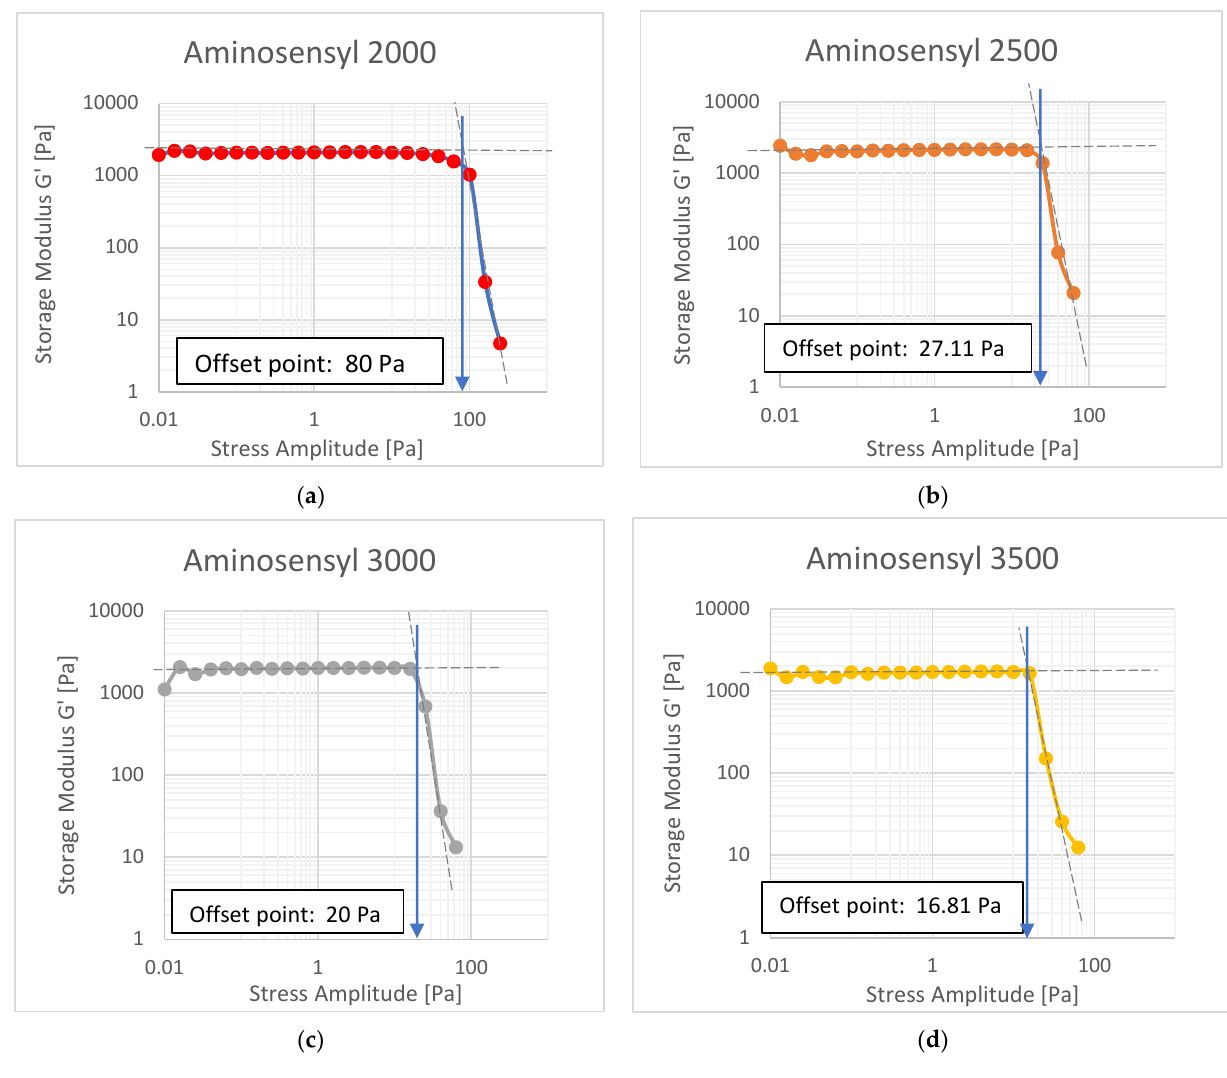
Figure 5. Yield stress of AS/FA samples formulated at varying shear mixing rates ( a ) 2000 rpm ( b ) 2500 rpm ( c ) 3000 rpm ( d ) 3500